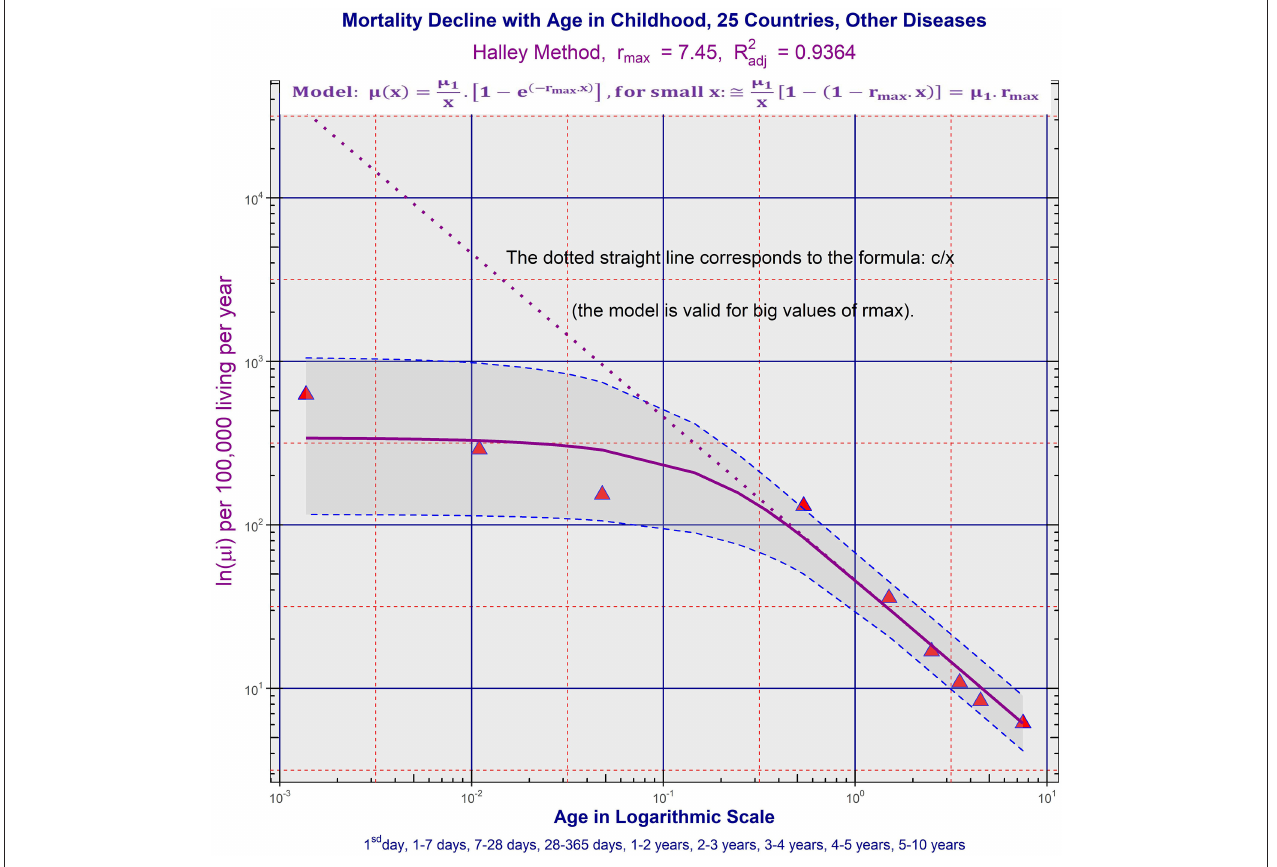
FIGURE 3 | Age trajectory of “Other diseases” in P25.